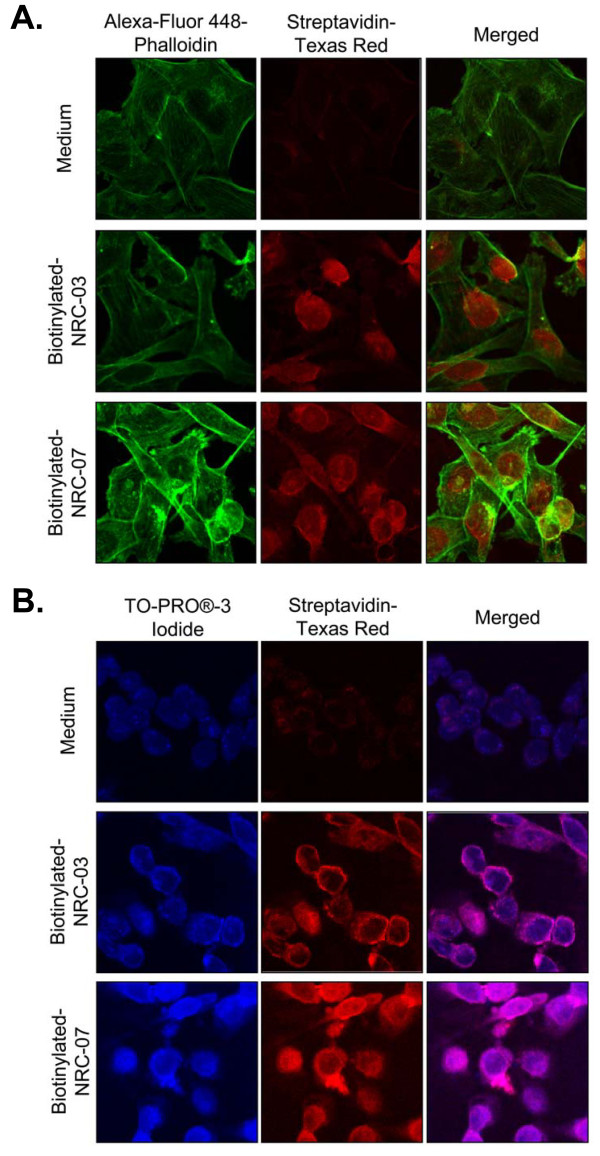
NRC-03 and NRC-07 enter breast cancer cells and localize to the nucleus. MDA-MB-231 breast cancer cells were cultured in the presence or absence of 50 μM biotinylated-NRC-03, or -NRC-07 for 30 seconds. (a) The actin cytoskeleton and biotinylated-peptides were visualized with confocal microscopy (×1,000) by using Alexa-Fluor 488-phalloidin and Texas Red-conjugated streptavidin, respectively. (b) The nucleus and biotinylated-peptides were visualized with confocal microscopy (×1,000) by using TO-PRO-3 iodide and Texas Red-conjugated streptavidin, respectively. Images shown are from a representative experiment (n = 3).